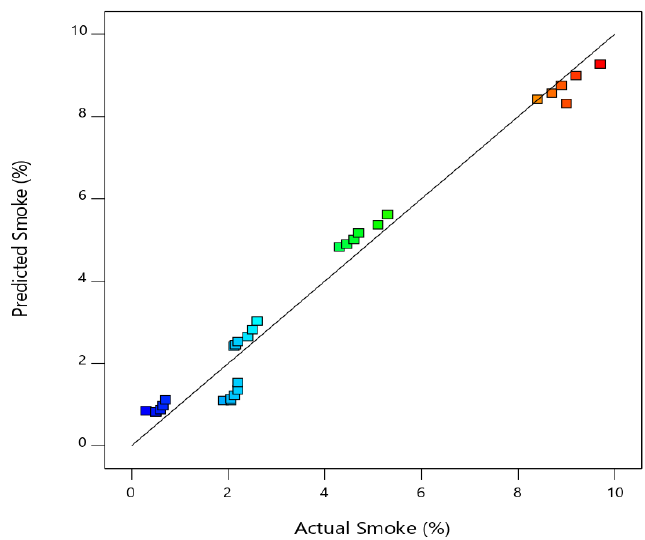
Figure 11. Comparison of actual and predicted smoke.